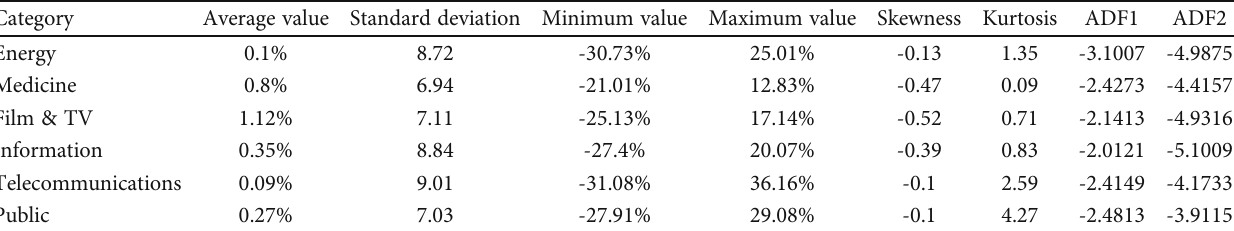
Table 6: Descriptive statistics and ADF tests by